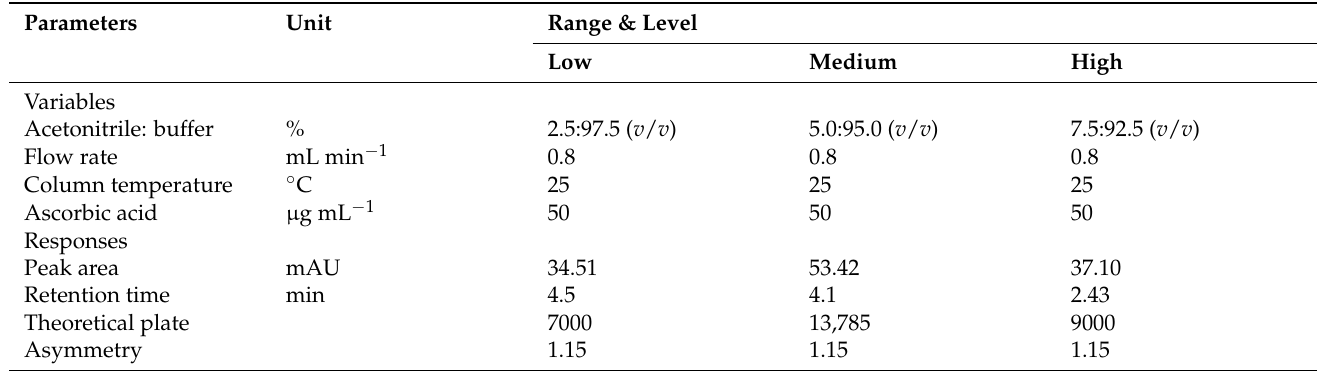
Table 5. HPLC responses at varied acetonitrile fractions with a constant flow rate and column temperature at 50 µg mL − 1 ascorbic acid.